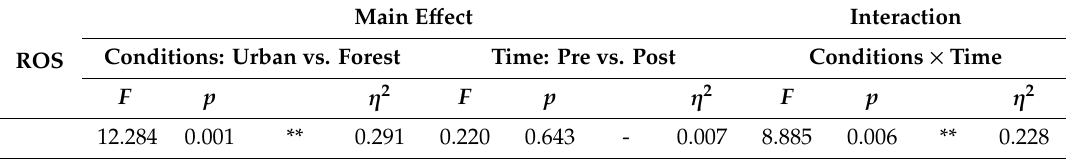
Table 8. Results of multiple comparisons of ROS scores for urban versus forest environments, as well as before and after environmental exposure. Urban Forest Pre Post Pre Post Average Pre Post Urban Forest Average